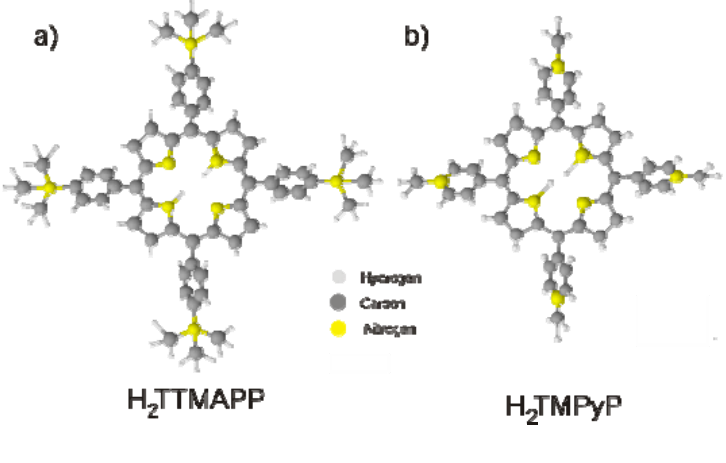
TTMAPP ( a ) and H TMPyP ( b ), respectively. 2 2